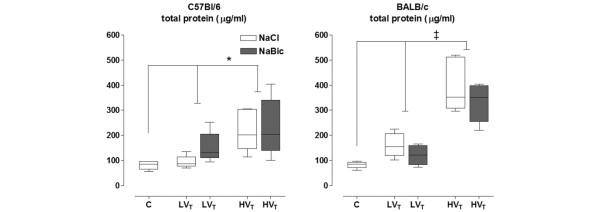
Total protein level in control mice and mice ventilated with low/high tidal volumes. Total protein level in control mice, and in mice ventilated with low tidal volumes (LVT) and high VT (HVT) for five hours. Two fluid strategies (normal saline (white boxes) and sodium bicarbonate (grey boxes)) were compared. Data represent median and interquartile range of six mice. *p < 0.05 (HVT vs. LVT); ‡p < 0.001 (HVT vs. LVT).